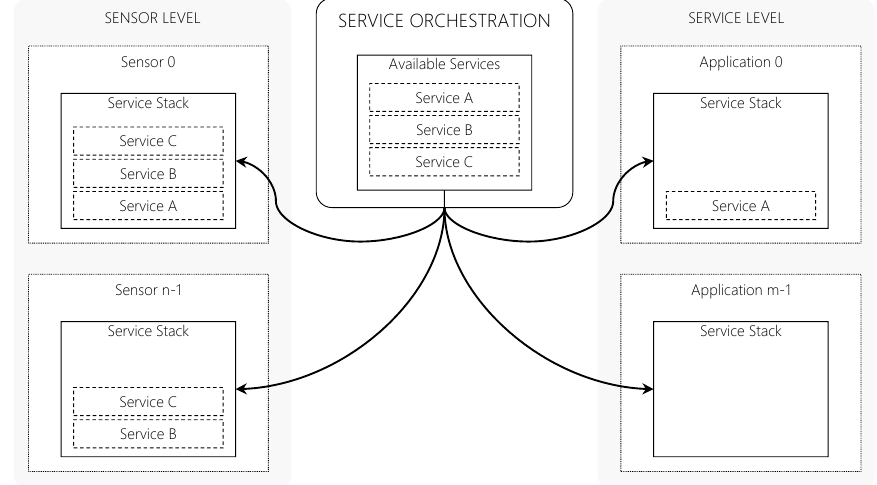
Figure 10. Example of the service orchestration process performed by the Orchestration